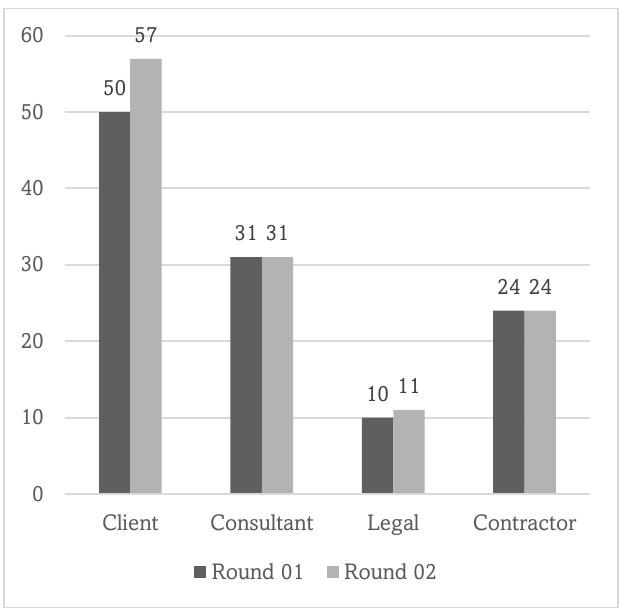
Fig. 4. Change of response between Delphi rounds using McNamara's